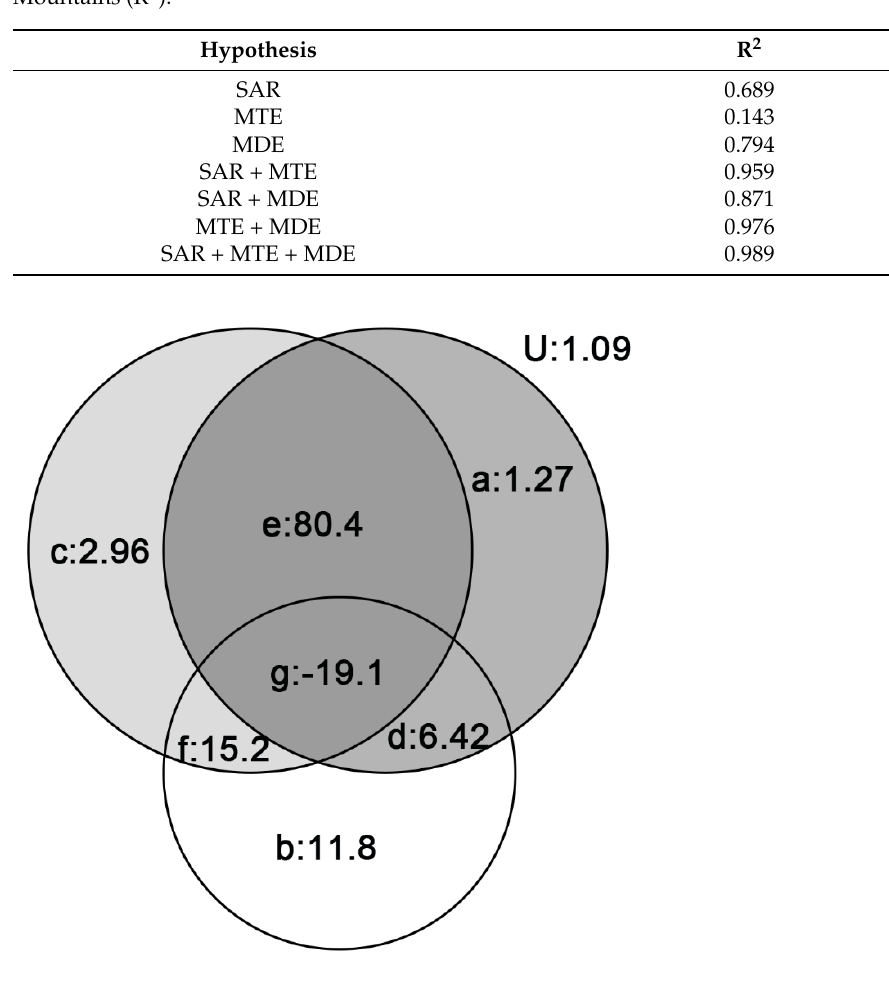
Figure 5. The relative contributions of the three hypotheses to explain the patterns of species richness. a, b, and c represent independent effects of SAR, MTE, and MDE; d, e, and f represent the interactions between them; g represents the combined effect of the three factors and u represents the unexplained quantity.